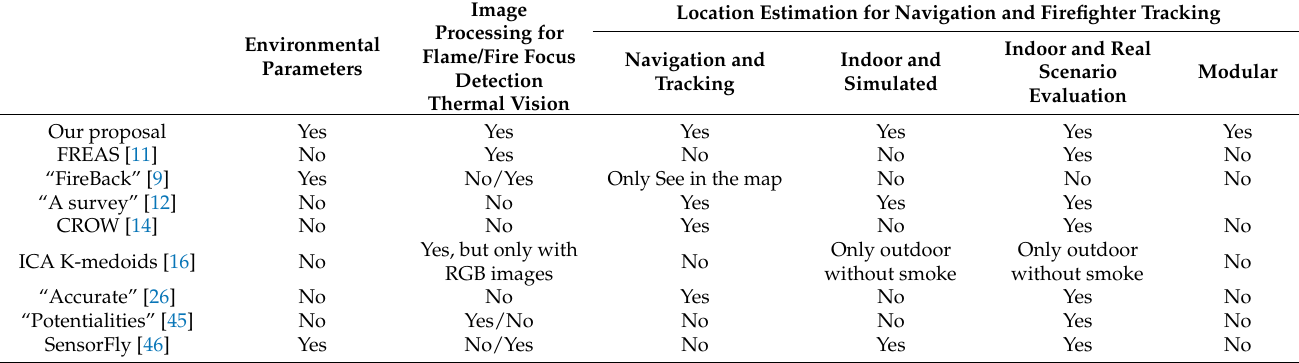
Table 8. Comparison of main